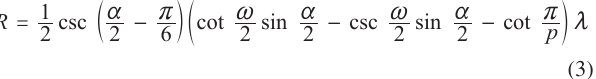
Figure 2. The four constructible ANHs of unit vertex to vertex distance. From left to right: N = 3, 4, 6, and 12, with their volumes approximately proportional to 0.350, 0.764, 2.11, and 9.25, respectively. Each unitary ANH in the interval 3 ≤ N ≤ 13 consists of a fixed volume enclosed by N identical convex curved faces intersecting at identical curved edges of unit chordal length between vertices. Edges meet three at a time at identical trihedral vertices. Vertices are symmetrically disposed about the volume centroid. All ANHs for N ≥ 14 have concave faces, and none are constructible.